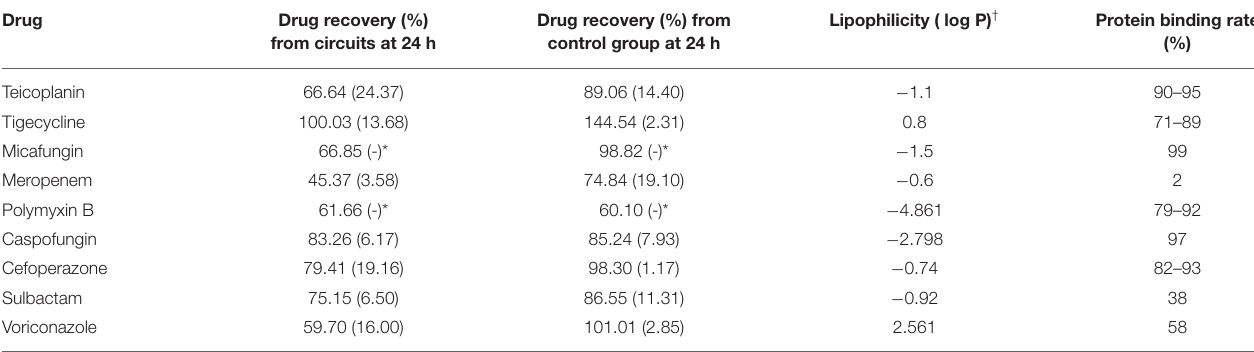
TABLE 1 | The log P - value and protein-binding rate of drugs and the extent of their loss in the blood-primed circuit at 24h. Drug Drug recovery (%)